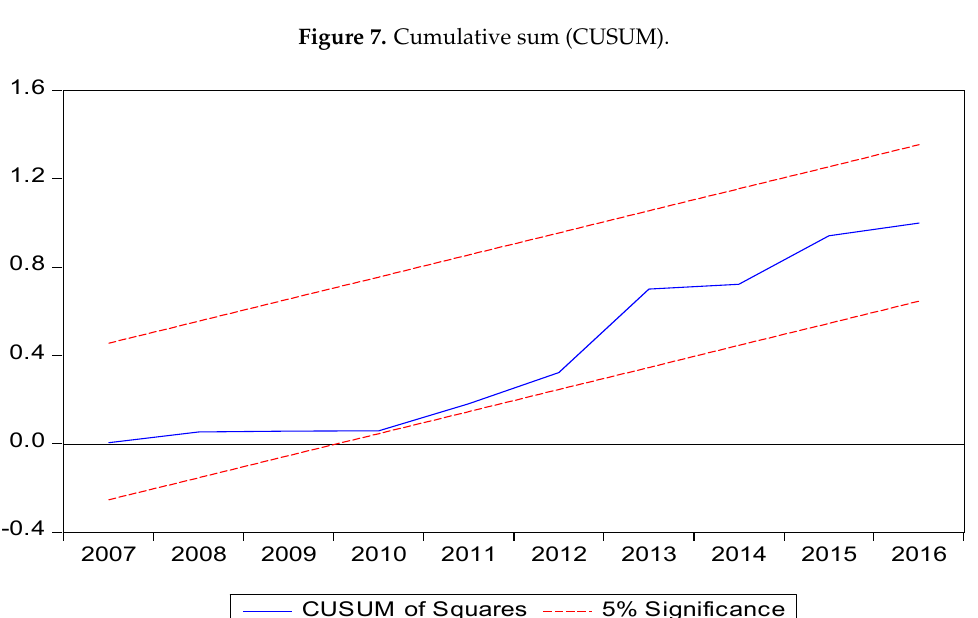
Figure 7. Cumulative sum (CUSUM).